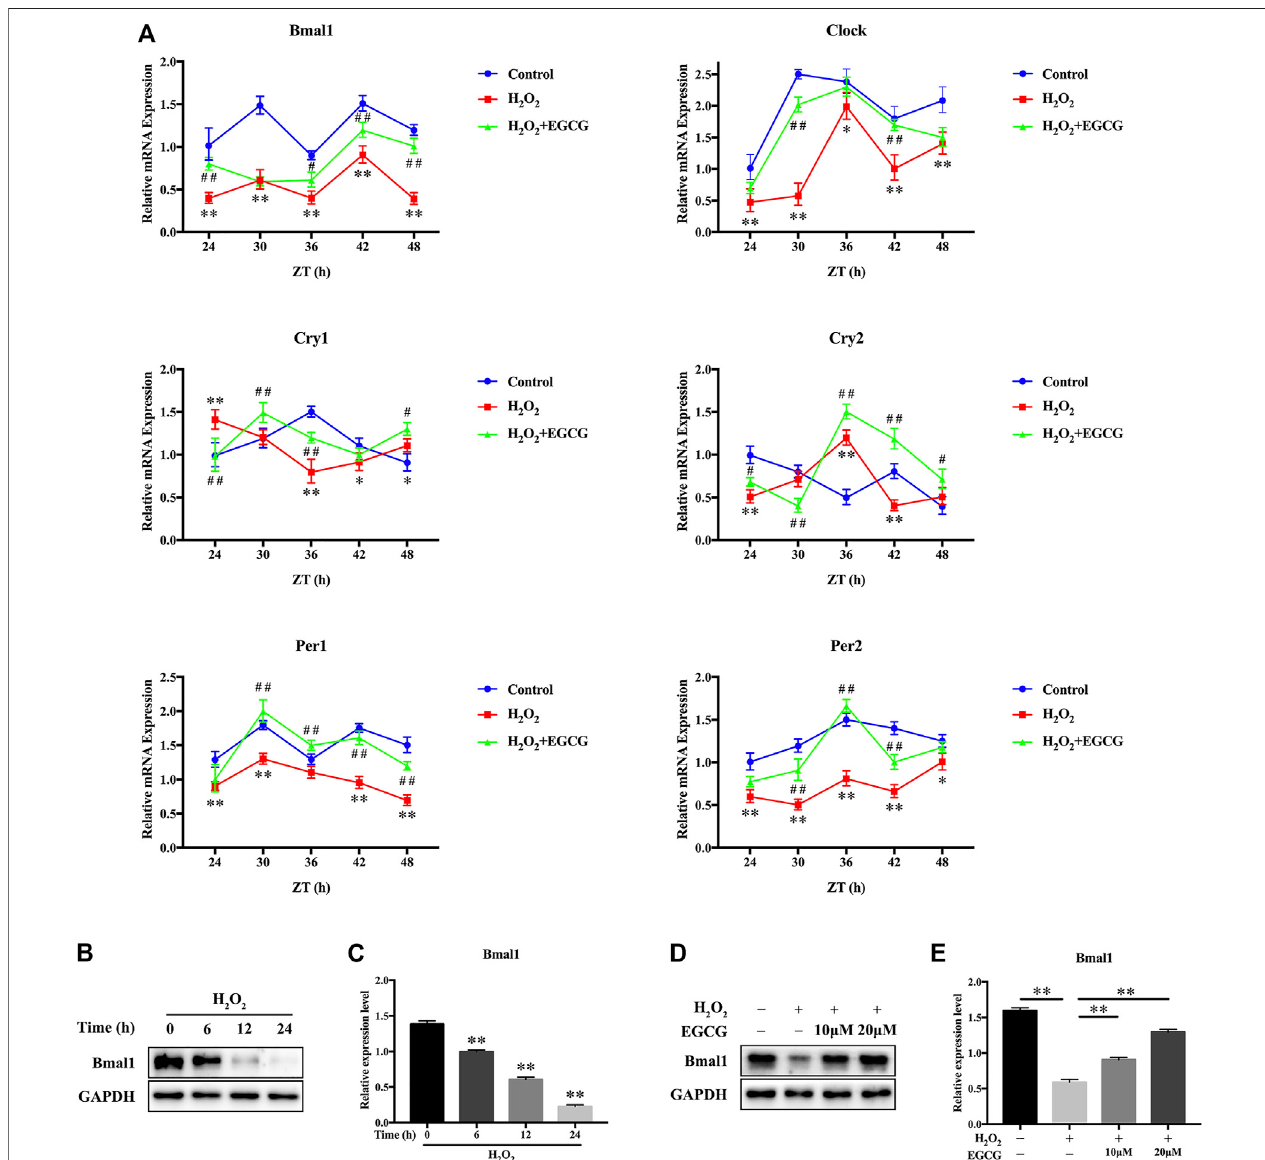
FIGURE 4 | Effects of EGCG against circadian misalignment in NPCs after exposure to H 2 O 2 . After 2 h of serum shock, NPCs were pretreated with 20 μ M EGCG for 12 h after which they were treated with 300 μ M H 2 O 2 for 12 h. Then, cells were obtained for mRNA analysis between the 24 and 48 h at 6 h intervals. (A) mRNA expression levels ofthe circadian oscillatorconstituents Bmal1, Clock, Cry1, Cry2, Per1, as well asPer2 in NPCs. Transcription levels were evaluated by qPCR followed bynormalization toGAPDHmRNAlevels. ZT, Zeitgebers(Germanfor “ timegiver ” ).* p < 0.05, ** p < 0.01, indicates H 2 O 2 vscontrol. # p < 0.05, ## p < 0.01, indicates H 2 O 2 + EGCG vs H 2 O 2 . (B) The Bmal1 expression changes after H 2 O 2 stimulation for different times were evaluated by western blot analysis, and GAPDH was the loading control. (C) Results of densitometric analyses of the blots. (D) NPCs were pretreated with varying EGCG doses for 4 h after which they were stimulated for 24 h usingH 2 O 2 .TheeffectsofEGCGonH 2 O 2 -triggeredBmal1expressionchangesweredeterminedbywesternblotanalysis,andGAPDHwastheloadingcontrol. (E) The results of densitometric analyses of the blots. The data are shown as mean ± SD ( n (cid:2) 3). * p < 0.05, ** p <